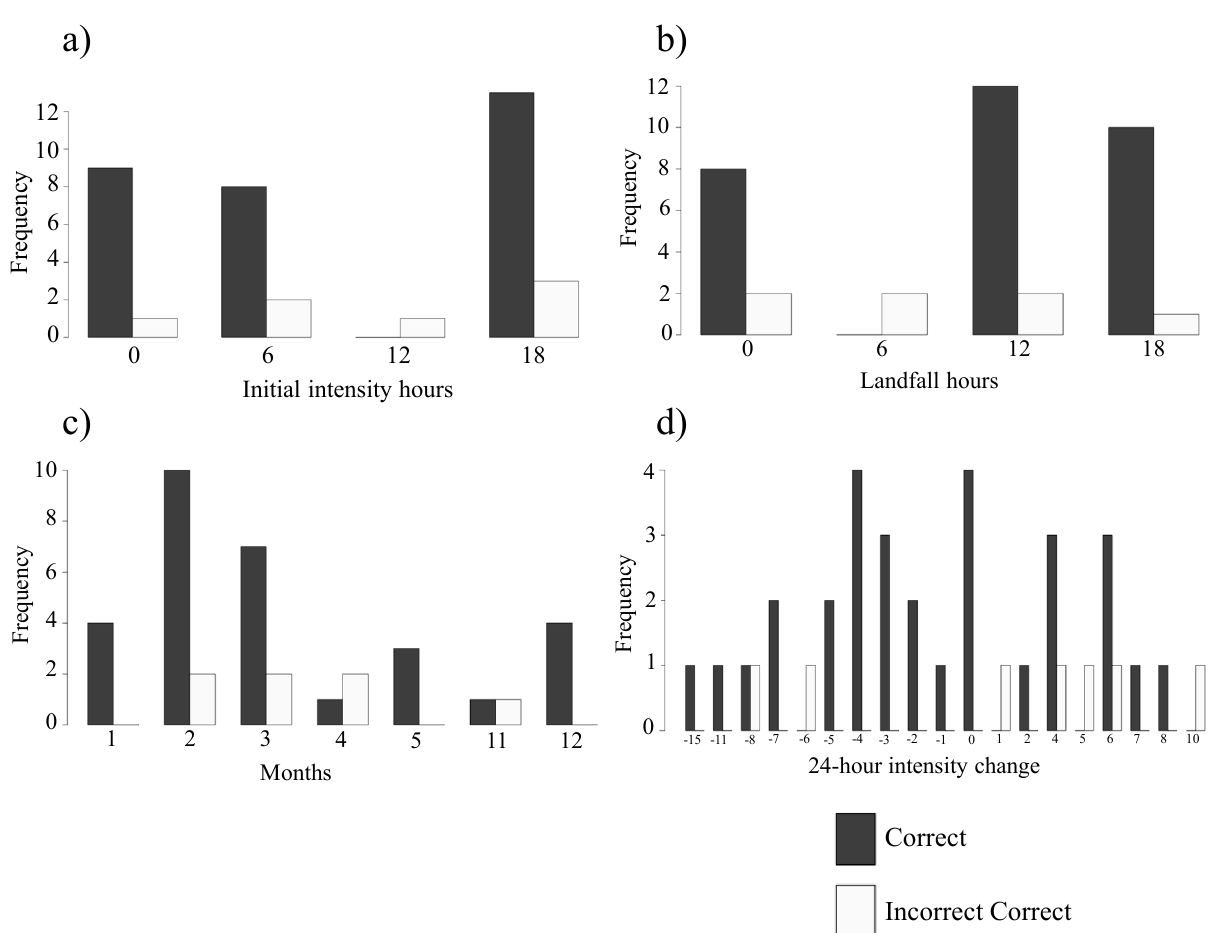
Figure 11. Bar plots that show the comparisons between correctly and incorrectly classified cases derived from both mainland and island random forest models for the testing data. Correct and incorrect classified cases during ( a ) initial intensity hour, ( b ) before landfall hour, ( c ) TC − occurring months, and ( d ) TC intensity change during 24 h time